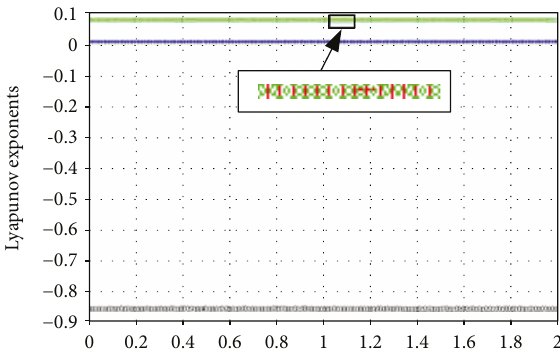
is turned on, S 2 1